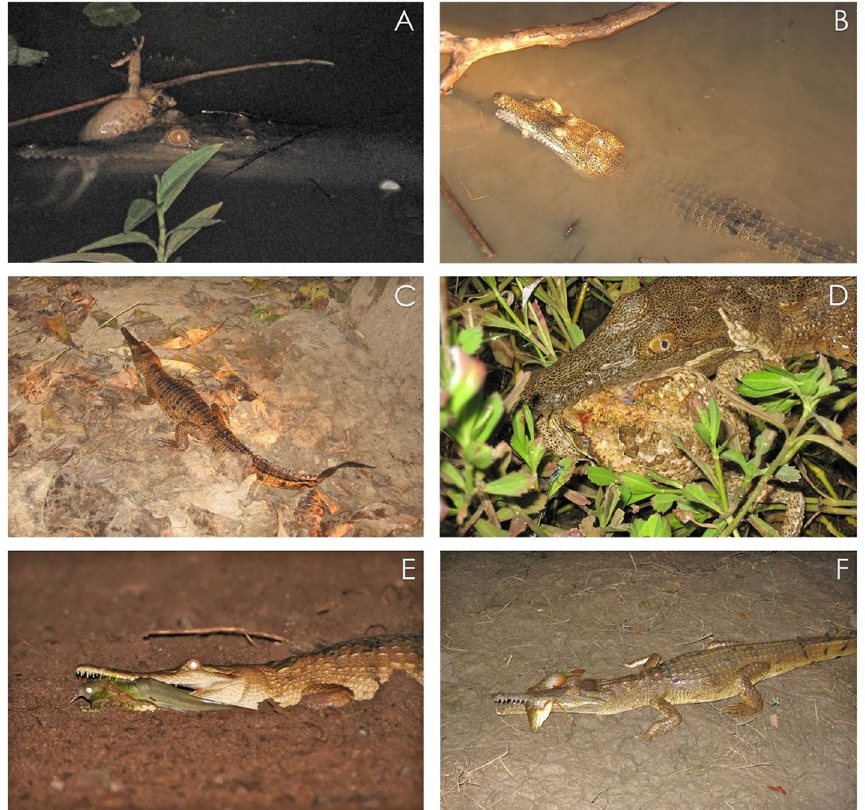
Figure 5. Freshwater crocodiles feeding on adult cane toads in the water ( A , B ) and on land ( C , D ). It is common for C. johnstoni crocodiles to consume prey on land, even if the prey is captured in the water ( E : a catfish; F : a small barramundi). Photographs by R.